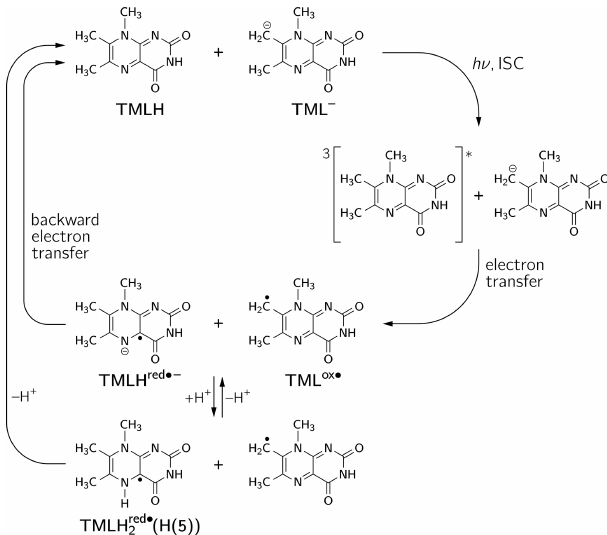
Figure 4. Photo-induced reversible disproportionation of 6,7,8- trimethyllumazine. ISC, intersystem